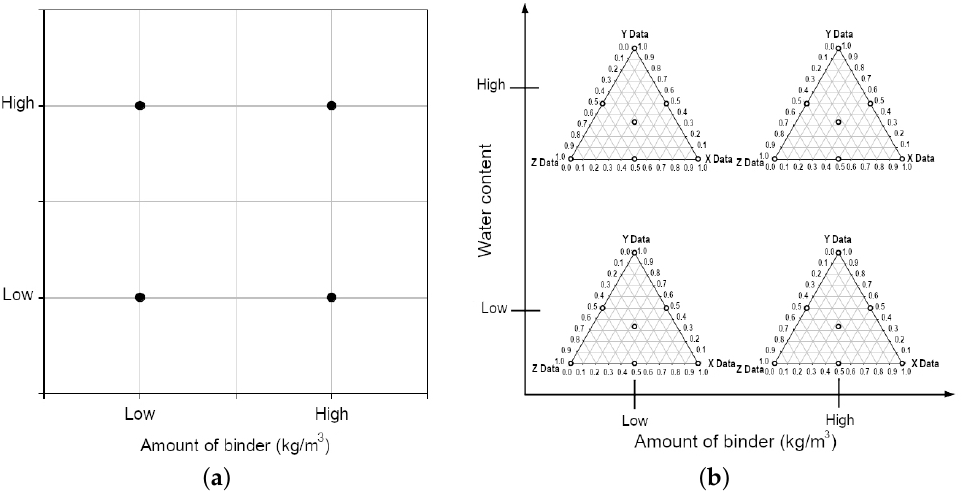
Figure 5. An example of a 2 2 -factor experiment with binder quantity and water ratio as factors ( a ); An example of a 2 2 -factor trial in combination with simplex trials ( b